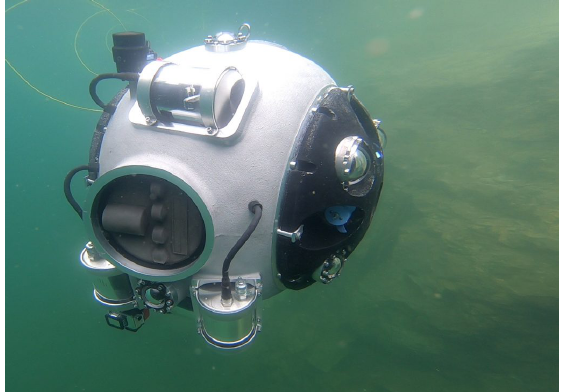
Figure 1. The UX-1 underwater vehicle during field trial in Kaatiala mine